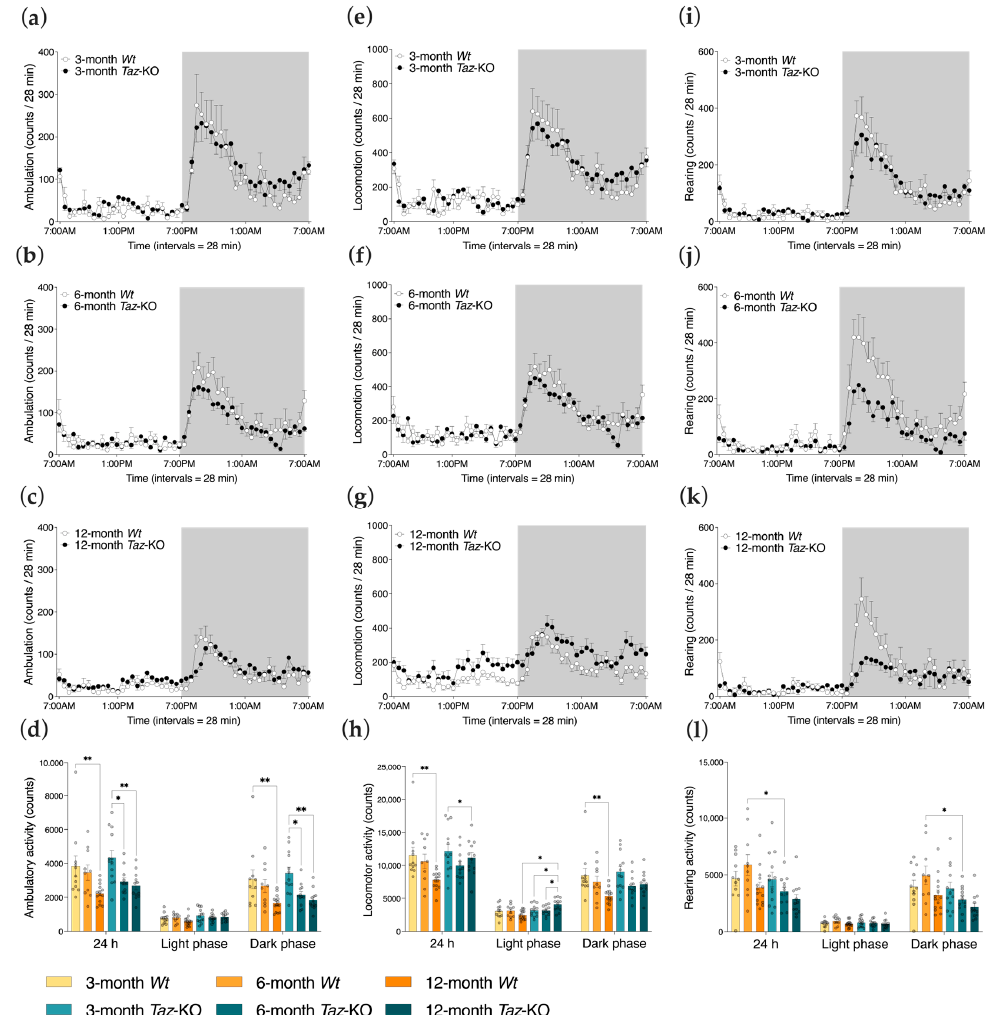
Figure 4. Basal activity levels are largely comparable in age-matched Taz -KO and Wt mice. Three separate mouse cohorts, aged 3, 6, and 12 months, were housed in metabolic chambers equipped with infrared beams. Representative plot of sums of infrared beam breaks per 28 min interval caused by ambulation movements, such as when a mouse transverses a chamber ( a – c ), locomotion movements, such as grooming and feeding in addition to ambulation ( e – g ), and rearing movements ( i – k ) over a period of 24 h. Dark (denoted by shaded background) and light (denoted by unshaded background) cycles are shown. The corresponding bar graphs of the total sum, in addition to sums per photoperiod, of beam breaks caused by ambulatory activity ( d ), locomotor activity ( h ), and rearing activity ( l ) for the cohorts. Statistical analysis was performed using two-way ANOVA followed by Bonferroni’s multiple comparisons tests ( d , h , l ). Data are means ± SEM ( n = 10–14). * p < 0.05, ** p < 0.01. Total locomotor activity, which is the sum of all horizontal and vertical cage move- ments of mice, was only different between the genotypes at 12 months of age (Figure 4e– h). The total locomotor activity of Wt mice decreased as they aged from 3 to 12 months, with longitudinal differences most discernable during the dark phase. Specifically, in the light phase, two-way ANOVA indicated significant effects of genotype ( p < 0.01) on total locomotor activity, with the effect of genotype dependent on age ( p < 0.01). Conversely, Taz -KO mice demonstrated significantly increased total locomotor activity from either 3